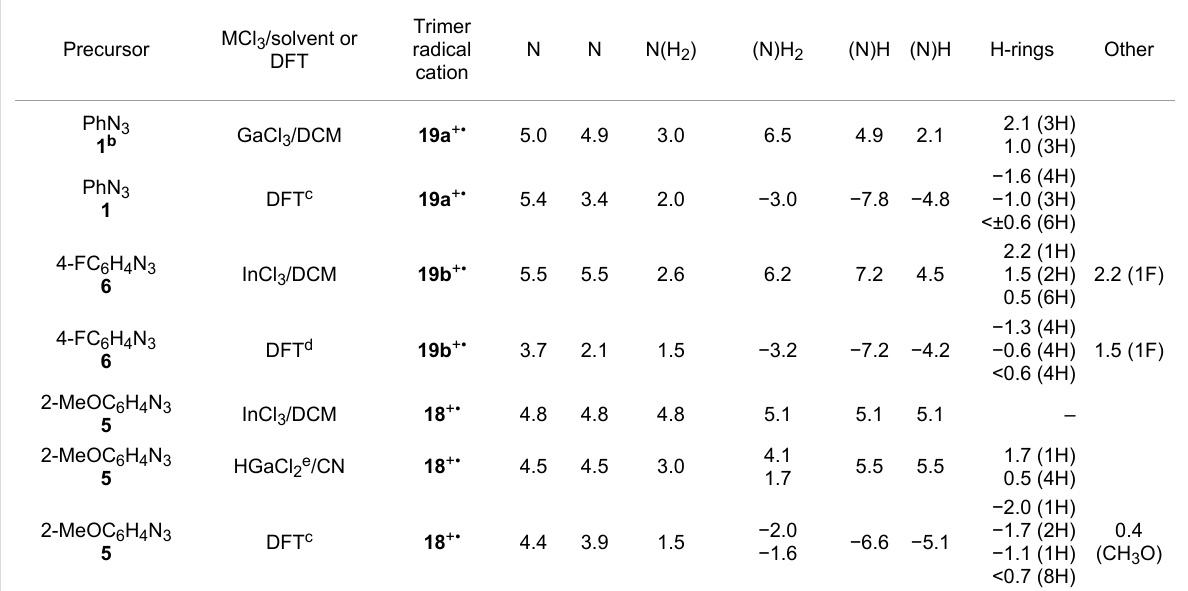
Table 2: EPR hfs of ‘trimer’ species {[ArNH] 2 C 6 H 4 NH 2 } +• from treatment of aryl azides with group 13 metal chlorides. a